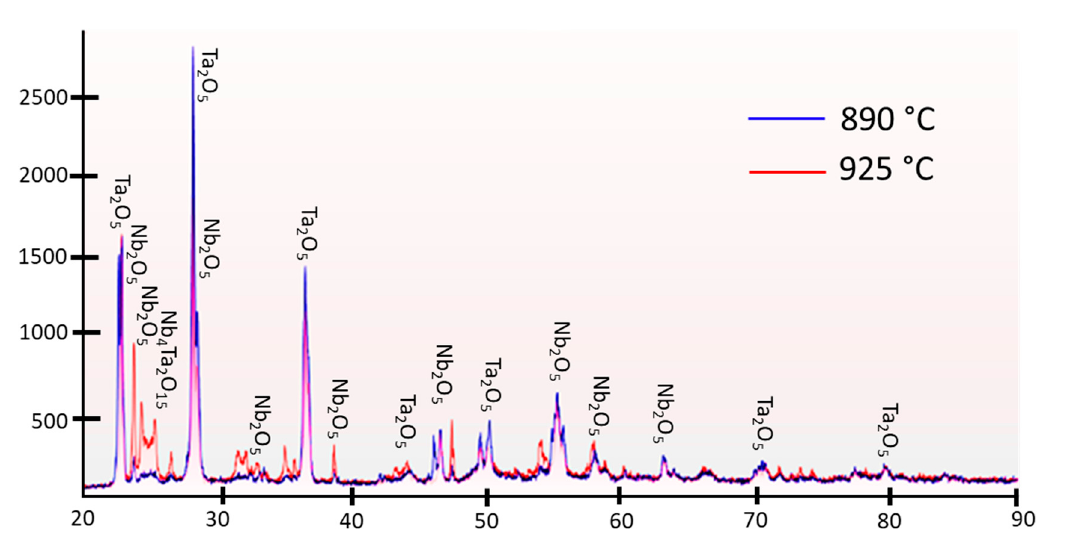
Figure 4. Overlay of the diffraction patterns recorded at two different temperatures (890 and 925 °C, respectively) for a 70 mol% Ta 2 O 5 and 30 mol% Nb 2 O 5 pellet, respectively.